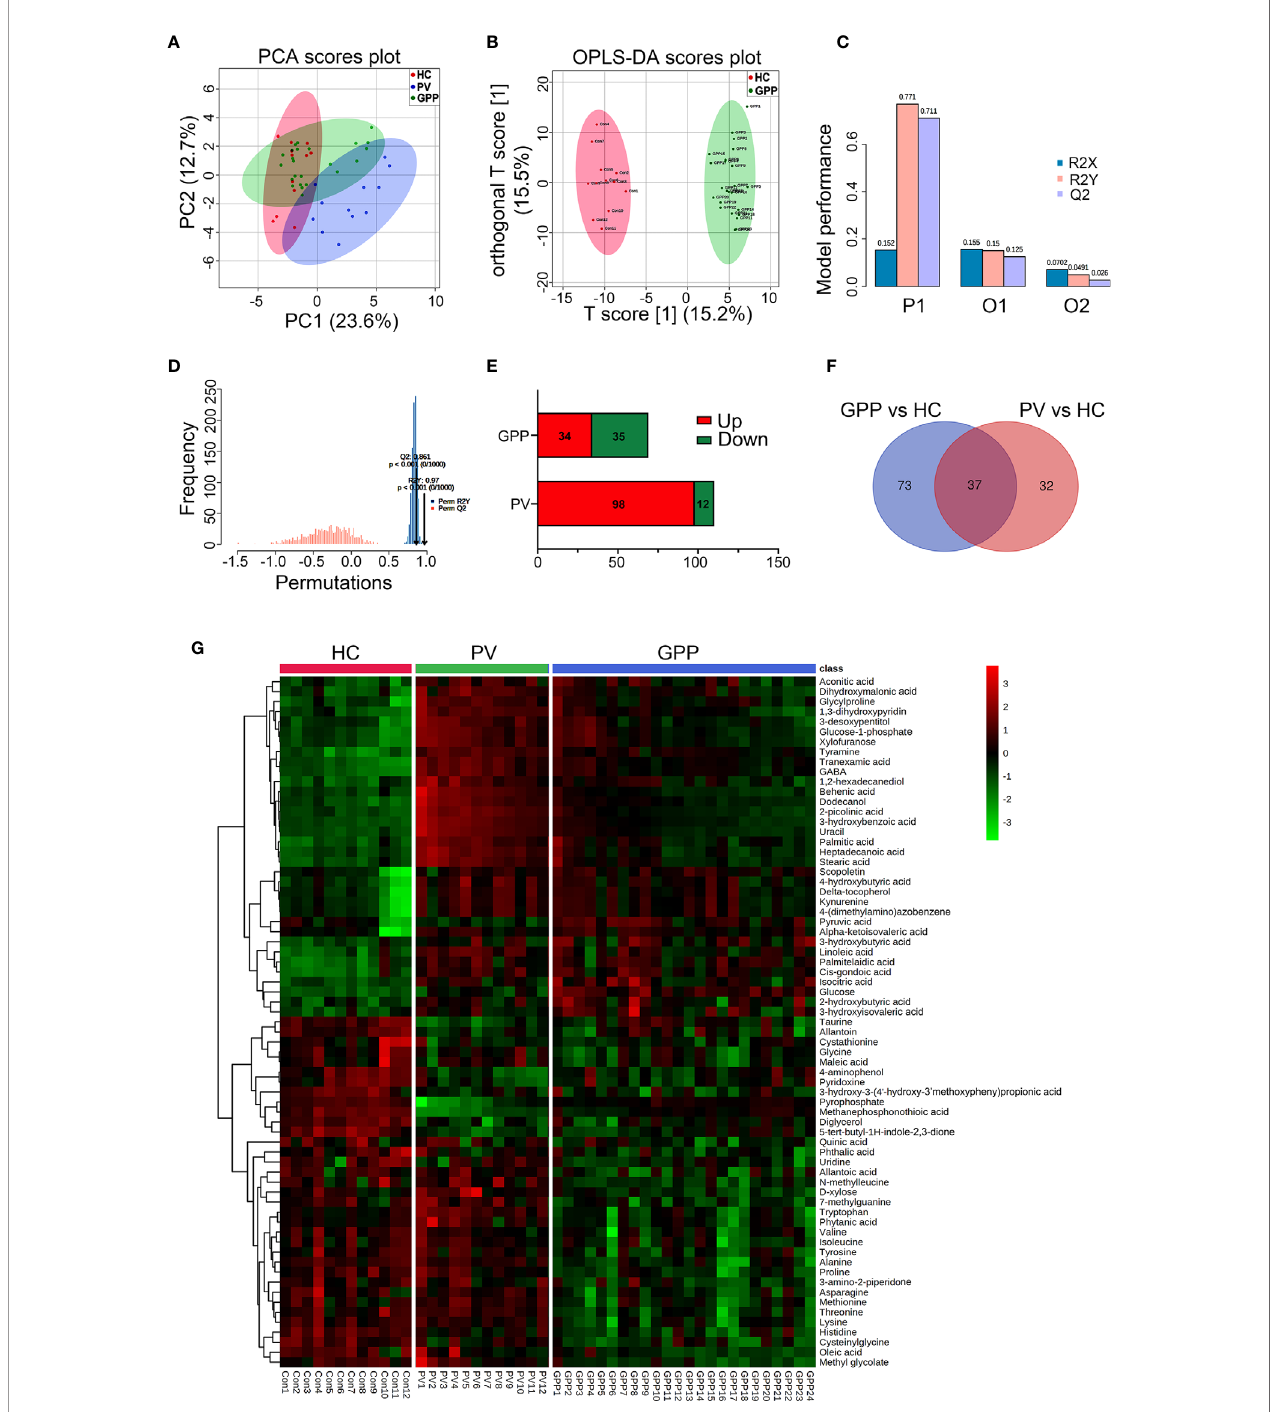
FIGURE 2 | Non-targeted metabolomics pro fi ling analysis for serum from GPP, PV and HC. (A) PCA scores plot of non-targeted GC-MS from the GPP (n = 24), PV (n = 12) and HC (n = 12) groups. (B) OPLS-DA score plots from the GPP (n =24) and HC (n = 12) groups. (C) Parameters of the OPLS-DA model (R 2 Y = 0.771, Q 2 Y = 0.711). (D) 1000-fold cross-validation of the OPLS-DA model by label permutation. P < 0.001 for R 2 Y and Q 2 Y. (E) Number of signi fi cantly different metabolites between GPP vs HC and PV vs HC. (F) The shared differential metabolites in the GPP vs HC and PV vs HC were visualized by Venn diagram. (G) Heatmap representing the contents of 69 differential metabolites, showing clear separation of GPP from PV and